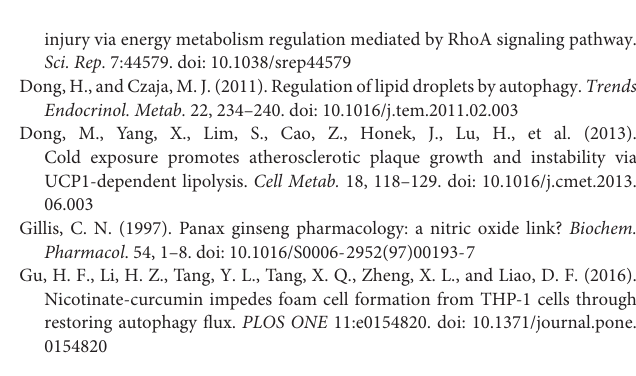
FIGURE S1 | Autophagy was impaired in macrophages by using Atg5 small interfering RNA (siRNA). (A) Representative western blots and (B) quantification of Atg5/ β -actin and LC3 II/ β -actin in macrophages transfected with con siRNA or Agt5 siRNA. ∗ p < 0.05, compared to the con siRNA group, n = 3. FIGURE S2 | Rb1 treatment promoted the expression of ABCA1 in macrophage foam cell. (A) Representative western blots and (B) quantification of ABCA1/ β -actin in macrophage foam cells treated in the presence or absence of 20 µ M Rb1. ∗ p < 0.05, compared to the control group; # p < 0.05, compared to the ox-LDL group, n =